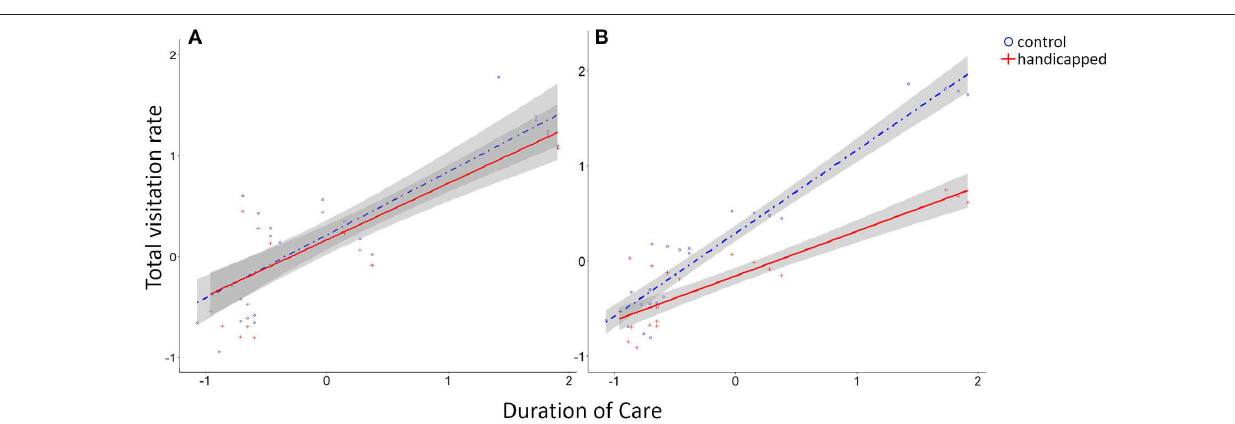
FIGURE 3 | Standardized model-predicted total visitation rates varied according to duration of care. (A) Handicapped and control groups had similar visitation rates during the pre-treatment phase. (B) Total visitation rates were lower in the handicapped group during the post-treatment phase, particularly for species with long durations of care. Shaded area represents 95% confidence